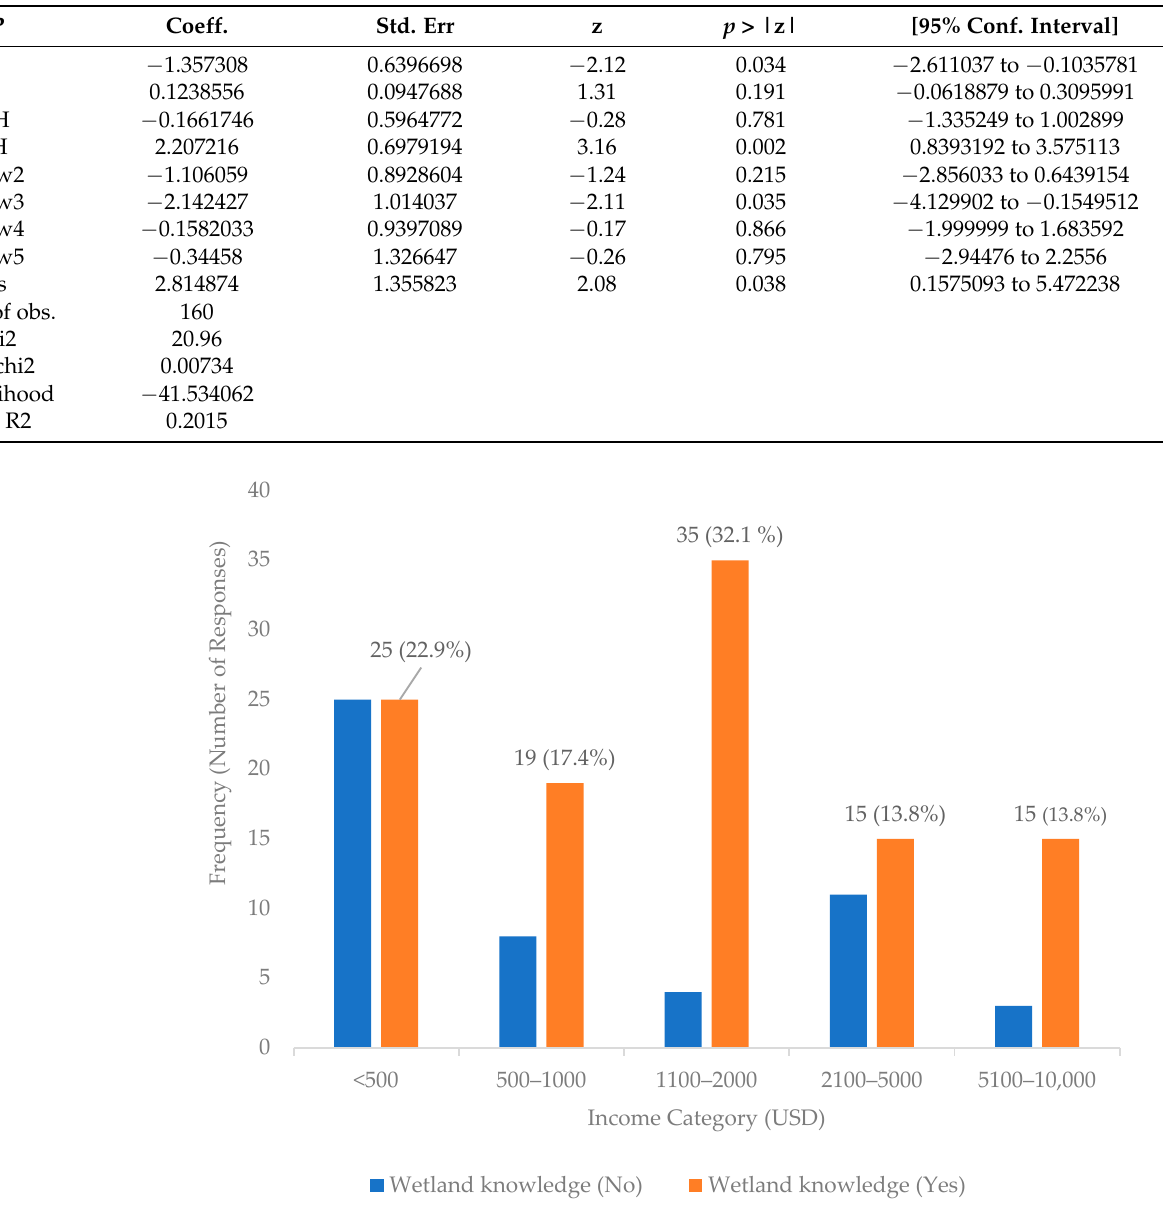
Figure 7. Income categories and knowledge about wetland ecosystems.